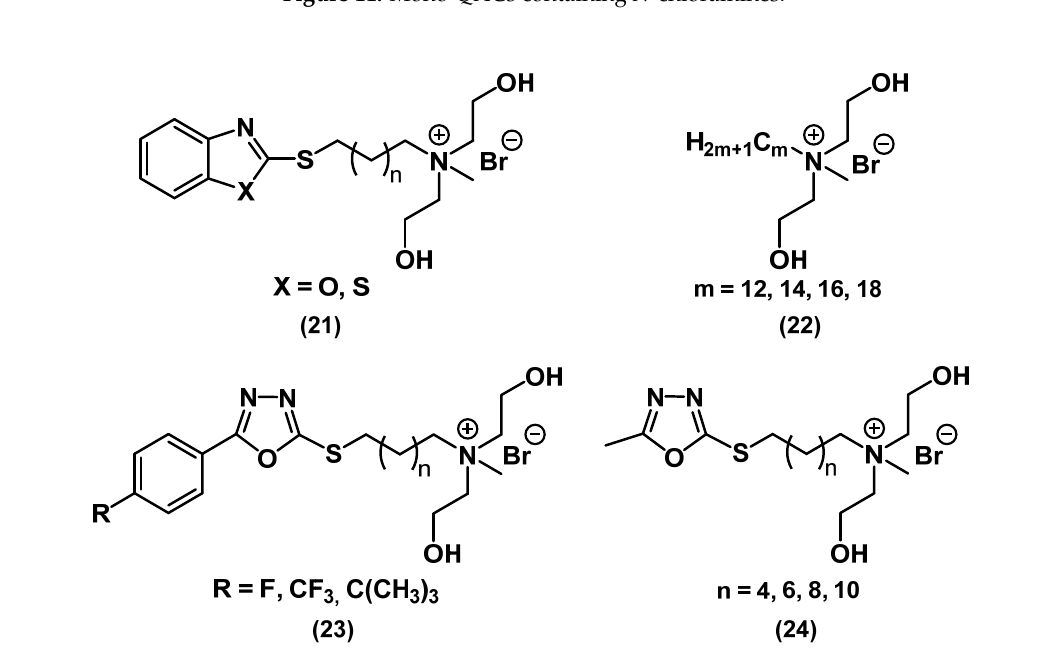
Figure 12. Mono-QACs containing hydroxyl groups.